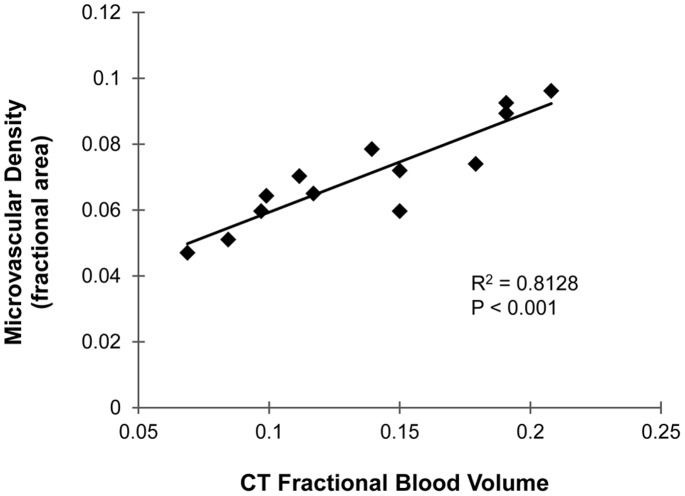
Microvascular density.Plot of microvascular density measured by CD31 immunostaining versus FBV measured by CT. Linear regression line is shown with the accompanying R2 value and p-value for the slope of the regression equation.